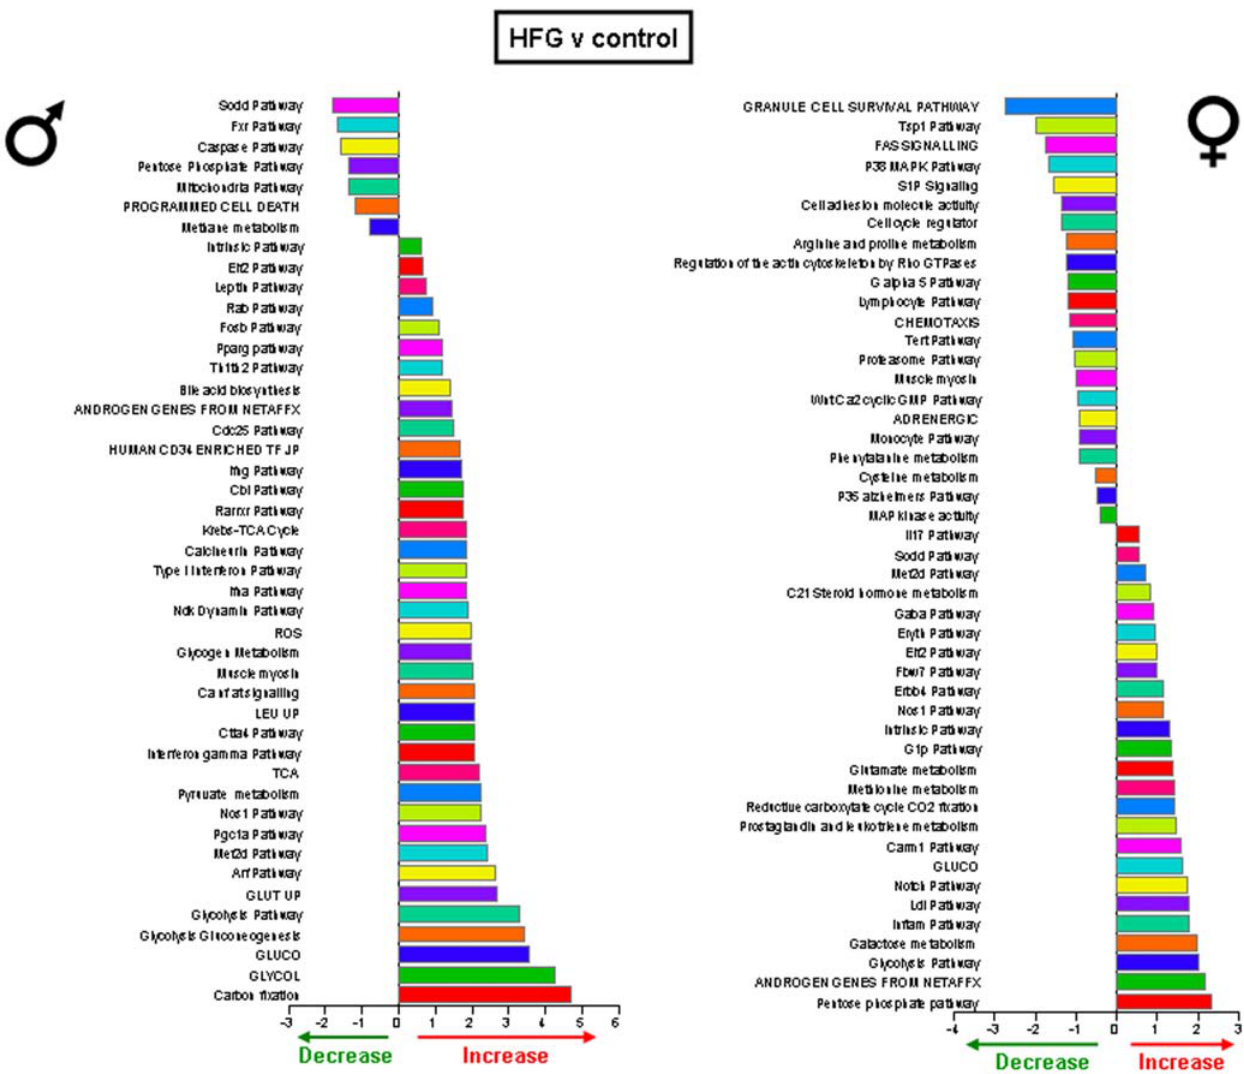
Figure 12. Significant gene pathway changes in the hippocampi of male and female rats maintained on a HFG diet. Significantly altered genes in the male and female hippocampi from the different dietary regimes were clustered into functional gene pathways. In the hippocampi from male rats on the HFG diet, there were 45 significantly altered gene pathways, of which 7 pathways were significantly down- regulated and 38 pathways were significantly up-regulated, compared to gene pathways in hippocampi from male control rats. Interestingly, the hippocampi from female rats on the HFG diet showed a very different functional gene pathway pattern as there were 47 significantly altered pathways, of which 22 were significantly down-regulated and 25 were significantly up-regulated, compared to gene pathways in hippocampi from control female rats.